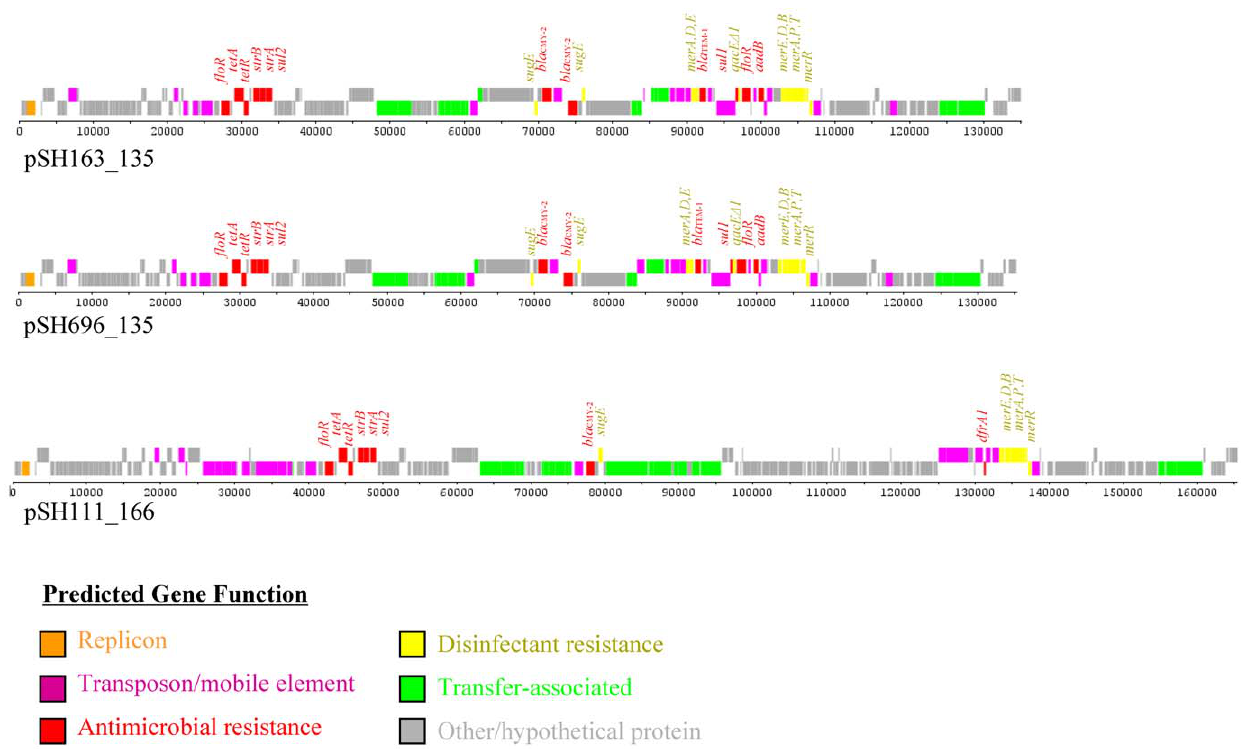
Figure 1. Linear representation of the IncA/C plasmids. For each of the plasmid diagrams the predicted functions of genes are identified by the colors indicated in the figure key. The predicted antimicrobial and disinfectant/heavy metal resistance genes are identified in plasmids pSH163_135, pSH696_135 and pSH111_166.